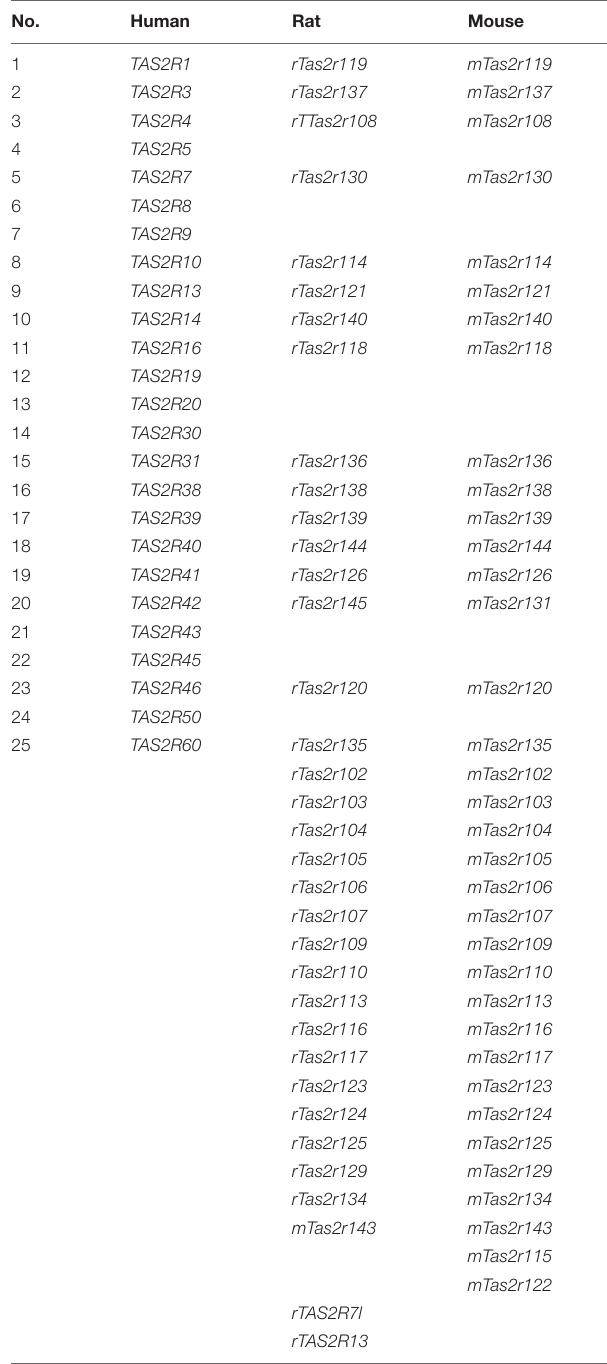
TABLE 2 | The orthologous genes in human, rat, and mouse (Foster et al., 2013).